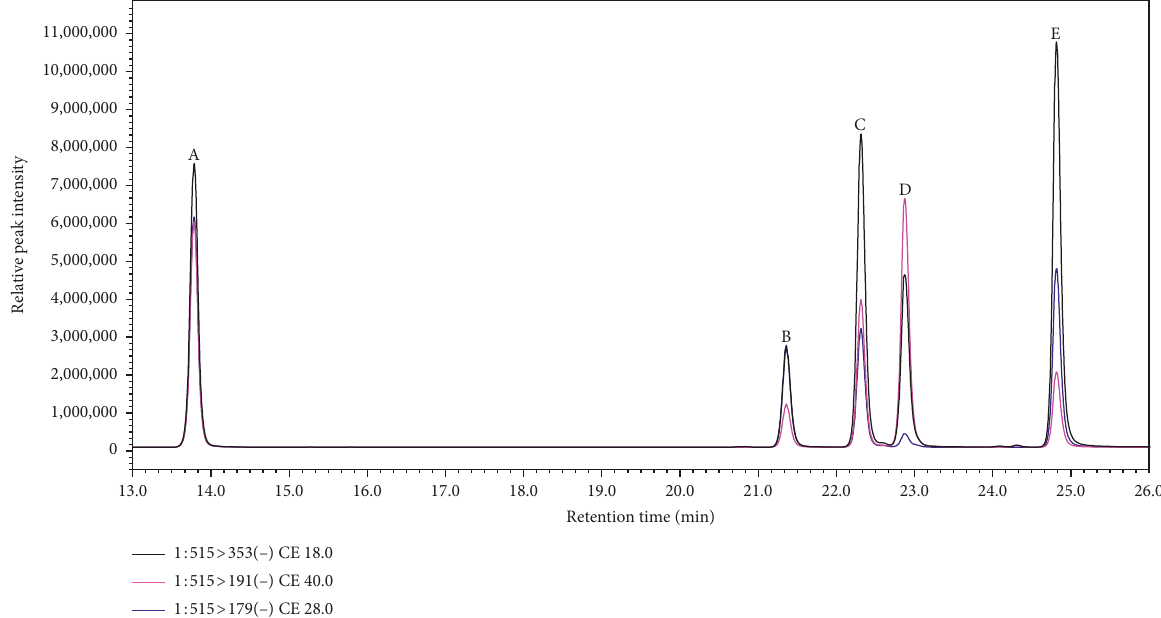
Figure 1: Chromatogram showing differences in the relative abundance of the MRM transitions of a sample containing a mixture of dicaffoylquinic acids (diCQAs) authentic standards: A Table 2: MRM transitions and MRM-dependent product ion scan of isomeric and isobaric compounds from different sample types. Sample